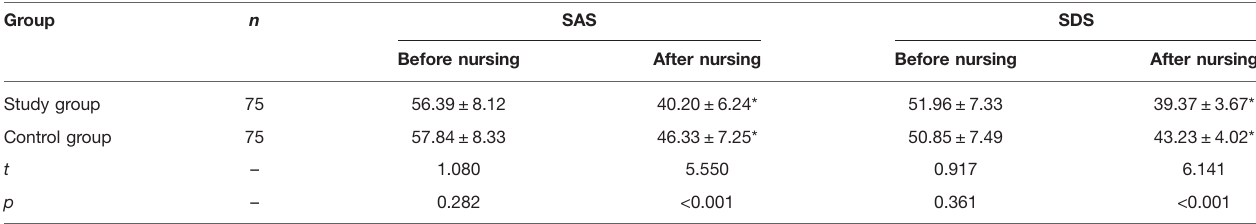
TABLE 3 | Comparison of SAS and SDS scores between two groups of children before and after nursing ( (cid:1) x + s, score). Group